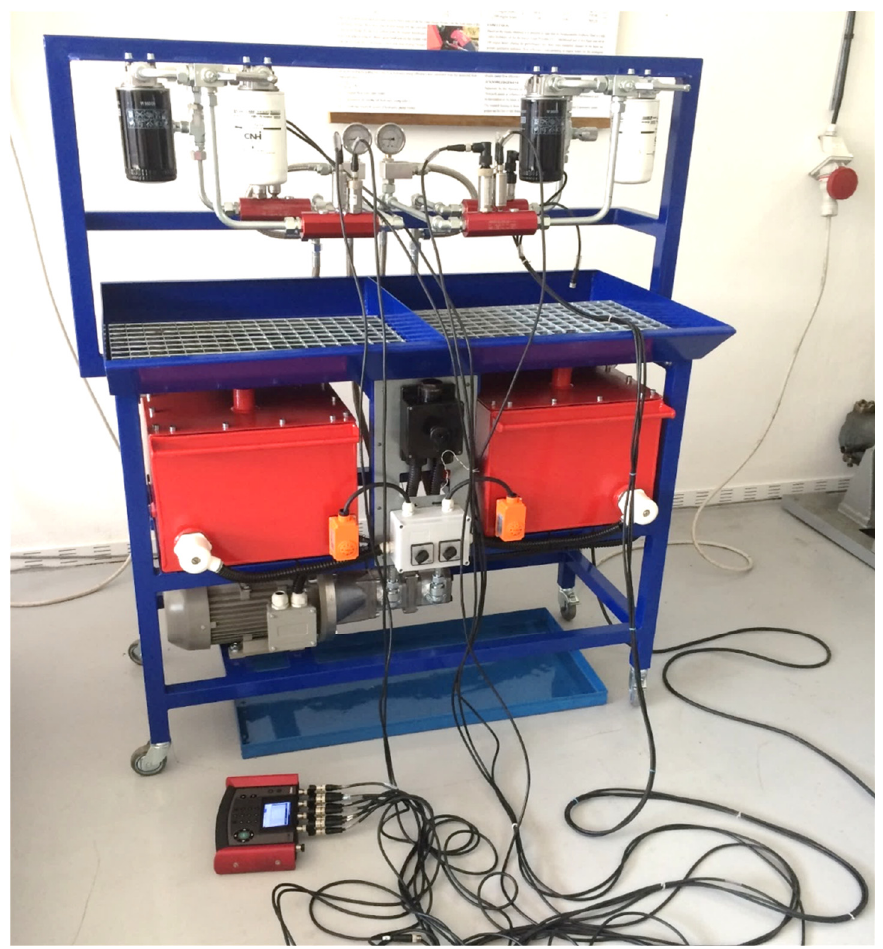
Figure 4. Laboratory test equipment for automotive oil filters to evaluate the technical life of en- gine